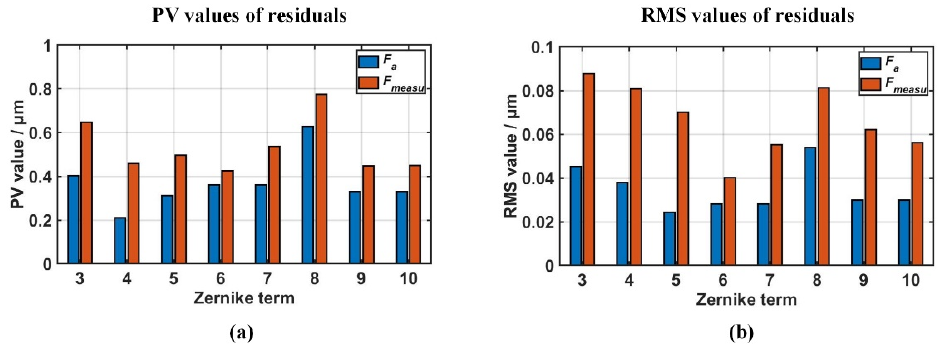
Figure 3. ( a ) PV and ( b ) RMS values of correction residuals of the 3rd–10th Zernike mode aberrations. The blue bars represent the correction results by using F a , and the orange bars by using F measu .